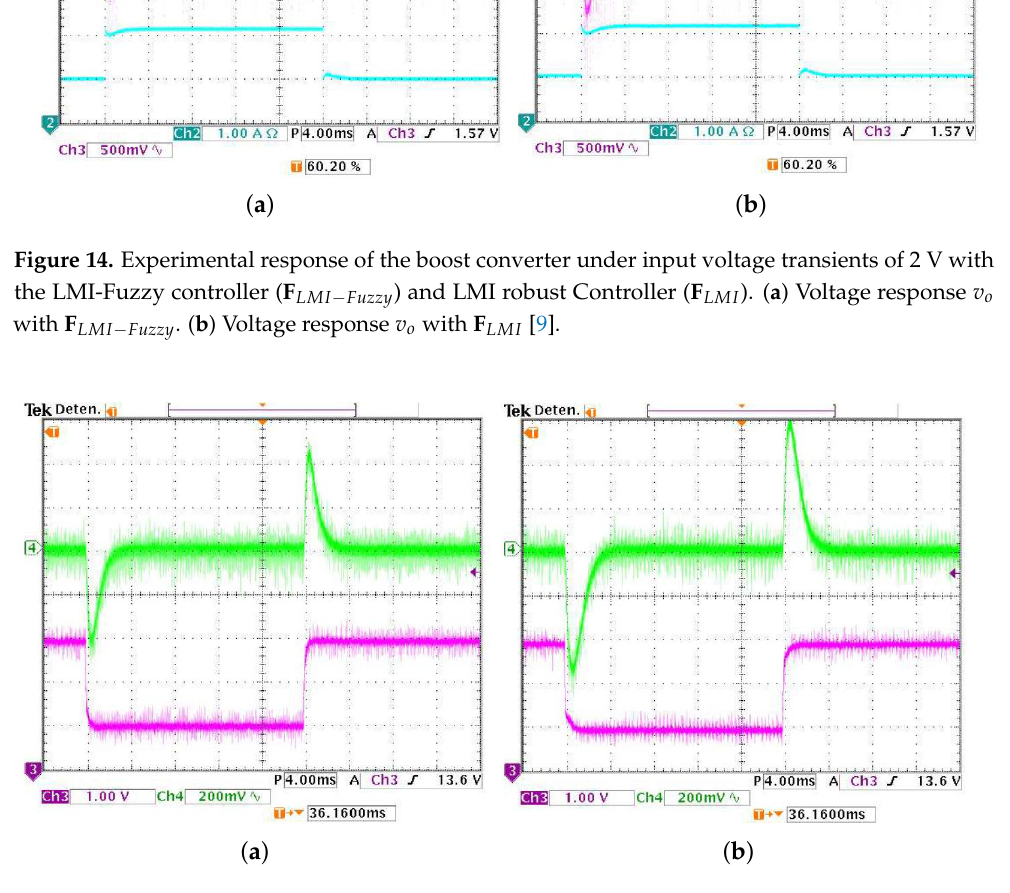
Figure 15. Experimental response of the boost converter under input voltage transients of 2 V with the LMI-Fuzzy controller ( F LMI − Fuzzy ) and LMI robust Controller ( F LMI ). ( a ) Voltage responde v o with F LMI − Fuzzy . ( b ) Voltage response v o with F LMI